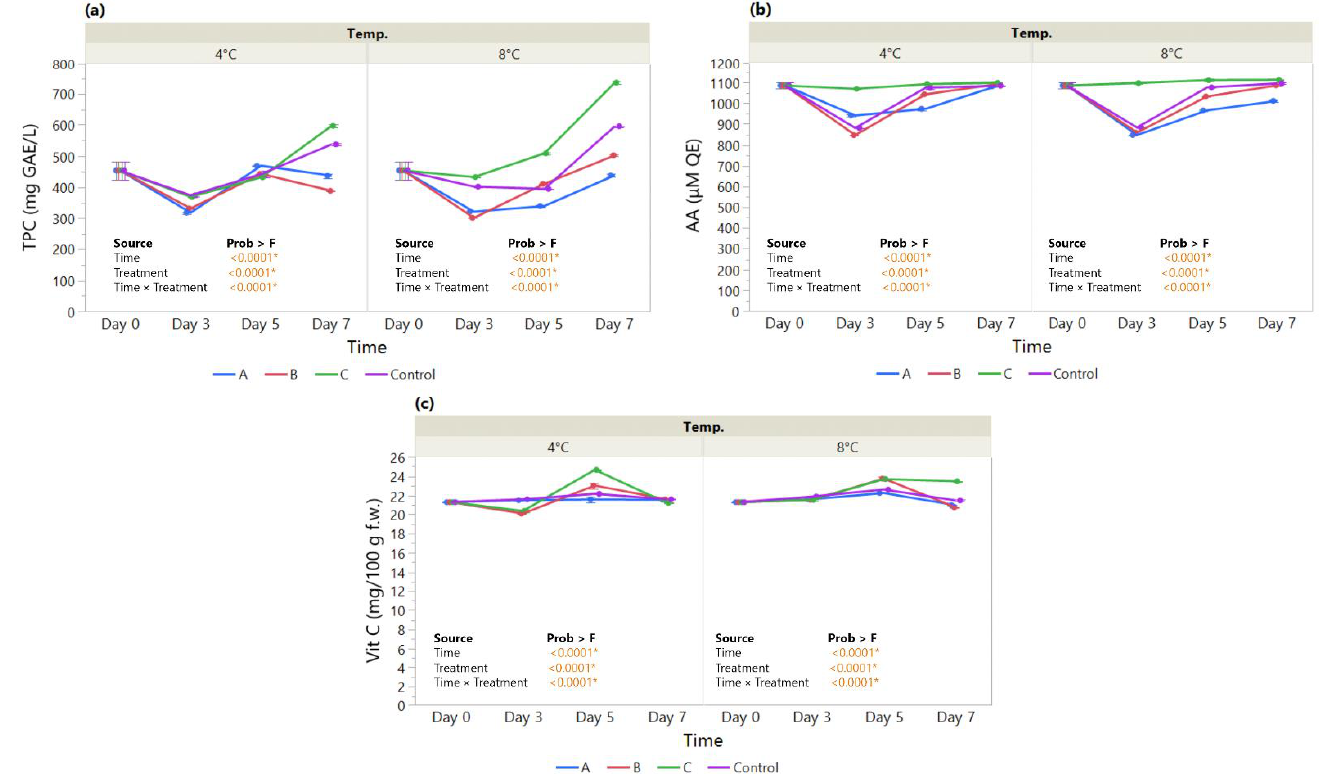
Figure 4. The effect of coating treatment on strawberry antioxidant status during a 7-day storage period at 4 °C and 8 °C. ( a ) Total Polyphenol Content (TPC — mg GAE/L); ( b ) Antioxidant Activity (AA —μM QE); and ( c ) Vitamin C content (Vit C — mg/100 g fresh weight). The p -values for the effects of Treatment (coating), Time and Interaction Treatment × Time are shown. Data are means ± SEM (n = 3). Asterisk (*) indicates significance ( p < 0.05*).